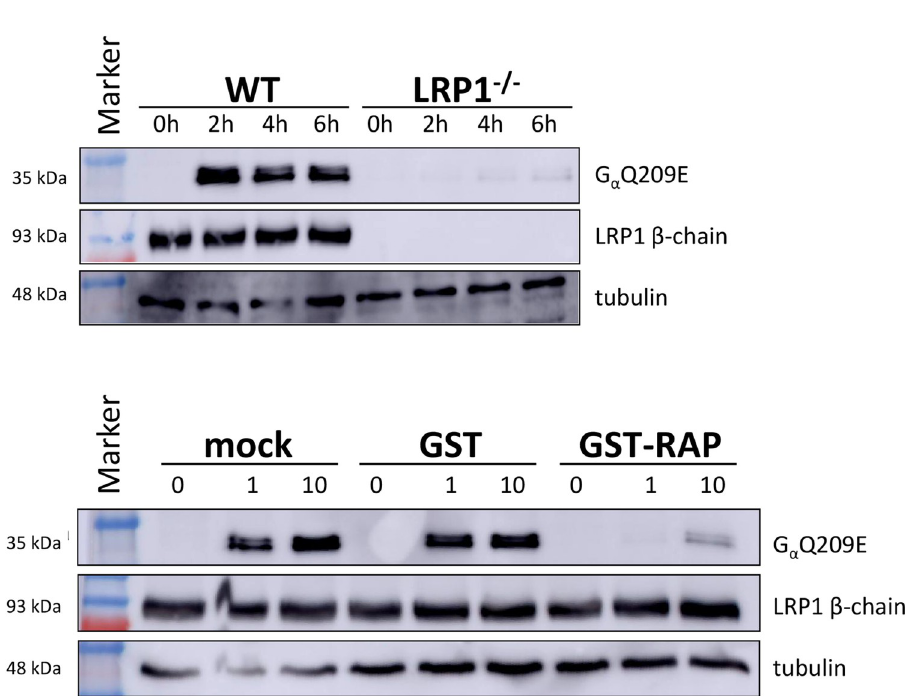
Fig 4. LRP1 knockout or competitive inhibition of LRP1 inhibit modification of PMT. MEF and MEF-LRP1 -/- cells were incubated in the presence of 5nM PMT for the indicated time intervals, washed and lysed. Lysates were analyzed for toxin-induced modification of G α q by an antibody detecting G α Q209E, for expression of LRP1 and for tubulin as loading control (top). MEF and MEF-LRP1 -/- cells were incubated in the presence of 1 or 10 nM PMT in the presence or absence of GST or GST-RAP (1 μ M), respectively, washed and lysed. Lysates were analyzed for toxin-induced modification of G α q, for expression of LRP1 and for tubulin as loading control (c, bottom). Statistics: � , p < 0.05; �� , p < 0.01; ��� , p <